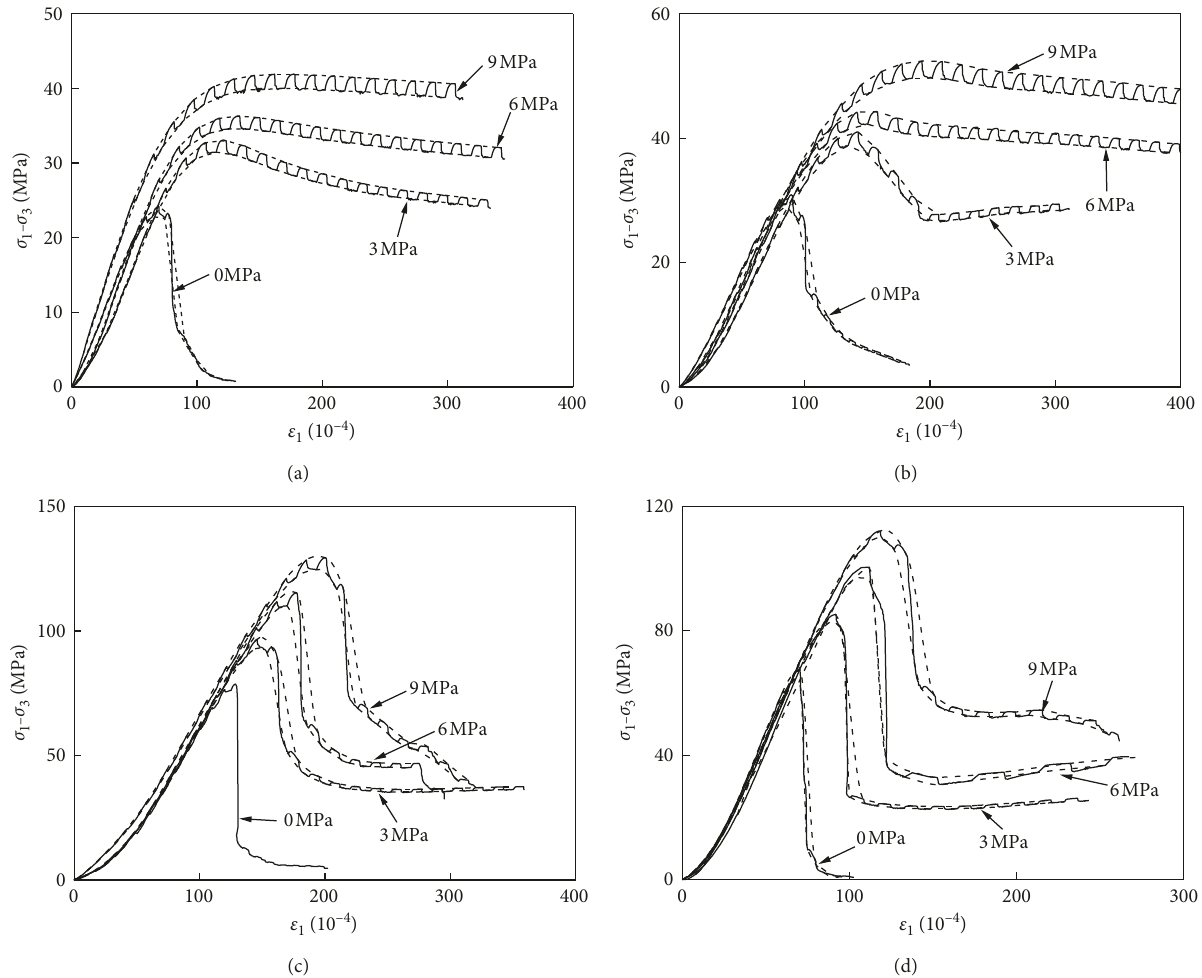
Figure 3: ASR stress-strain curves of air-dried rocks: (a) Tage tuff, (b) Ogino tuff, (c) Emochi andesite, (d) Jingkou